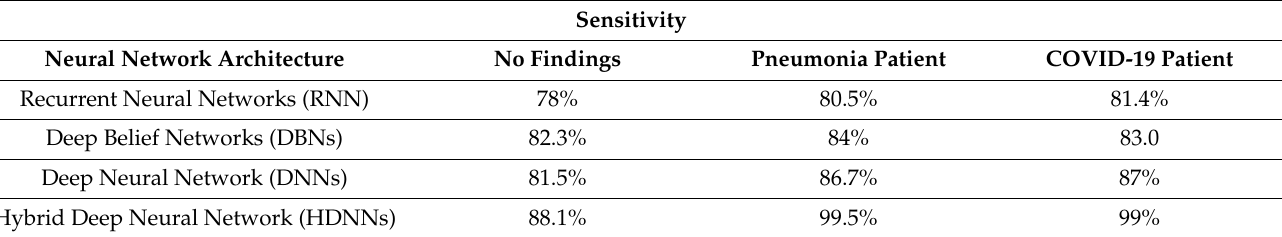
Table 2. Sensitivity for Normal, Pneumonia Patient, and COVID Patient.